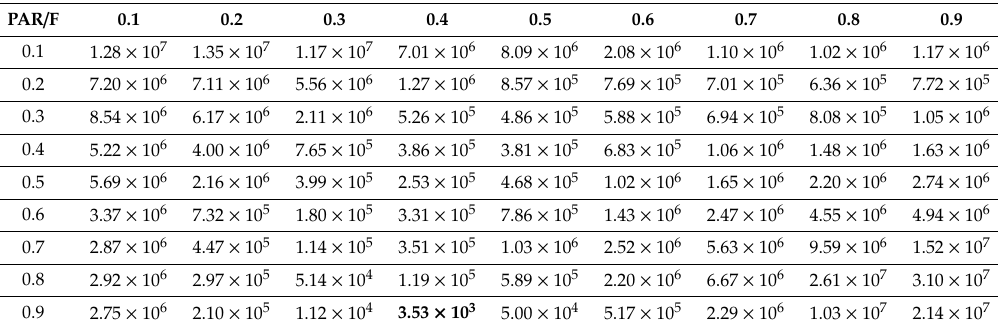
Table 1. Fitness of f1 for di ff erent parameters ( PAR , F